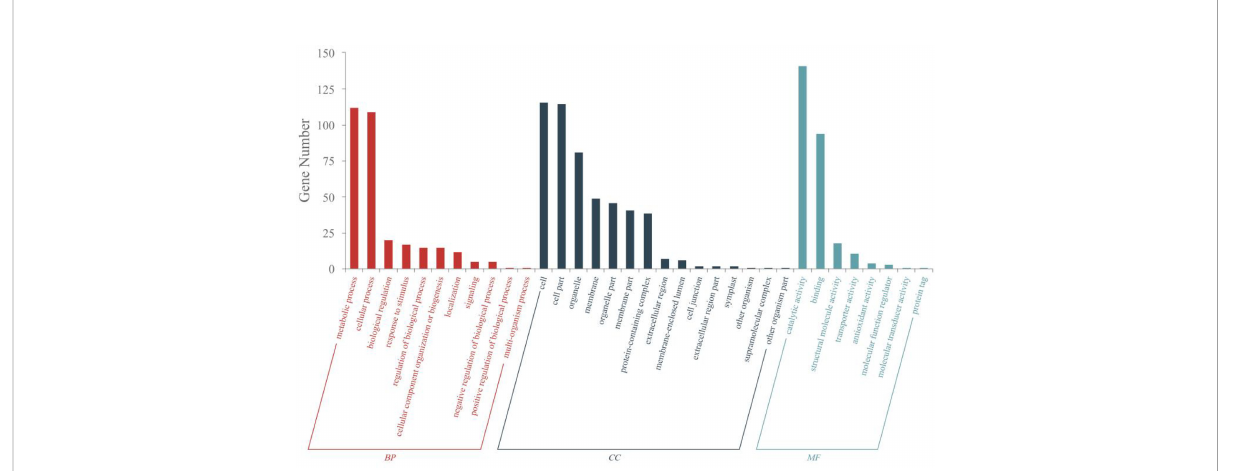
FIGURE 5 GO annotation statistics of DEPs (P value <0.05) of “ CK+TMV ” and “ A16+TMV ” .